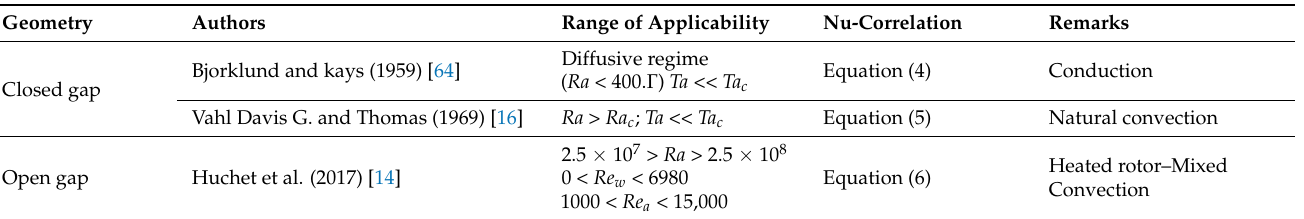
Table 3. Scaling relationships obtained in rotating annular ducts in diffusive, natural and mixed regimes of